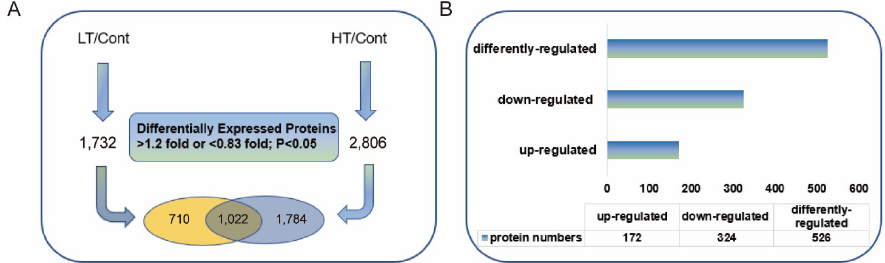
Figure 2. Summary of temperature stress-responsive proteins under low temperature (LT) and high temperature (HT) treatments. ( A ) Number of differentially expressed proteins in wucai leaves under LT and HT treatments compared to control. The value shared by the two ovals indicates the number of commonly regulated proteins, i.e., proteins that were di ff erentially expressed relative to the control under both LT and HT treatments. ( B ) Distribution of commonly regulated proteins (1022 proteins) by LT and